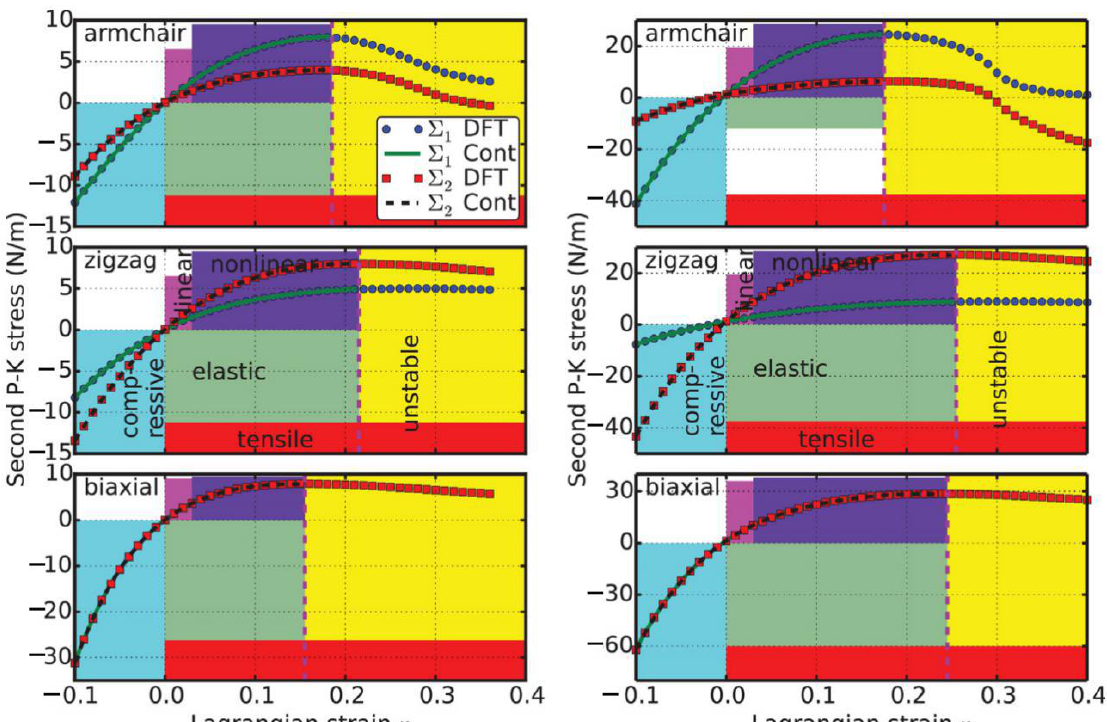
Figure 19. Stress–strain responses of g-InN ( left ) under the armchair, zigzag, and biaxial strain, compared with g-BN ( right ). Σ 1 ( Σ 2 ) denotes the x (y) component of the stress. “Cont” stands for the fitting of DFT calculations (”DFT’’) to continuum elastic theory.